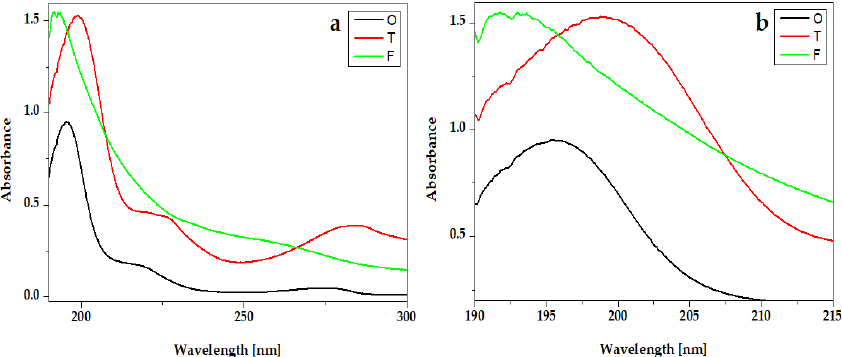
Figure 4. UV-VIS absorption spectra of essential oils Oregano ® (O), Thieves ® (T), and Frankincense ® (F): ( a ) full-length spectra and ( b ) peaks details.